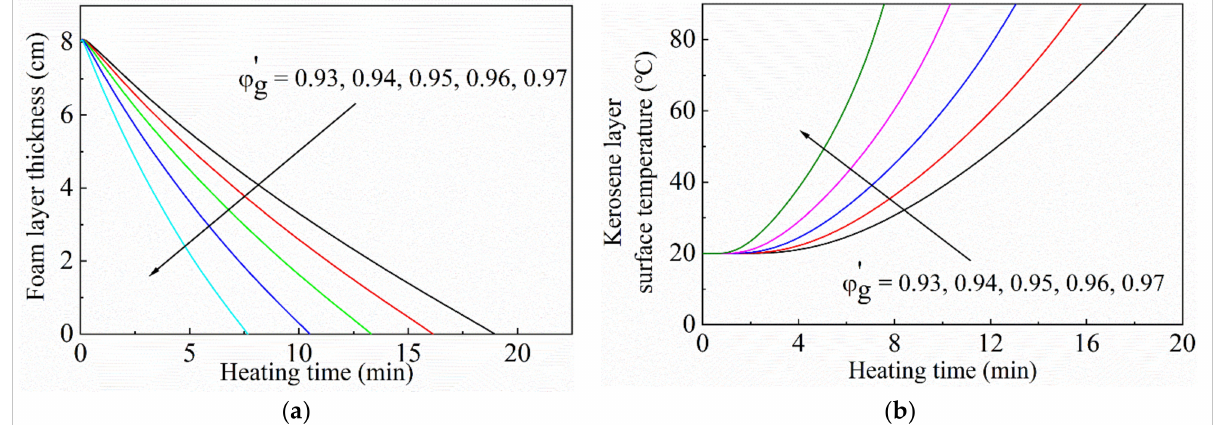
Figure 8. Curves of ( a ) the foam layer thickness and ( b ) surface temperature of the kerosene layer with different initial gas volume fractions. The particle concentration was 1.0 vol%, and the particle size was 30 nm. Initial thickness of the foam layer was 8.0